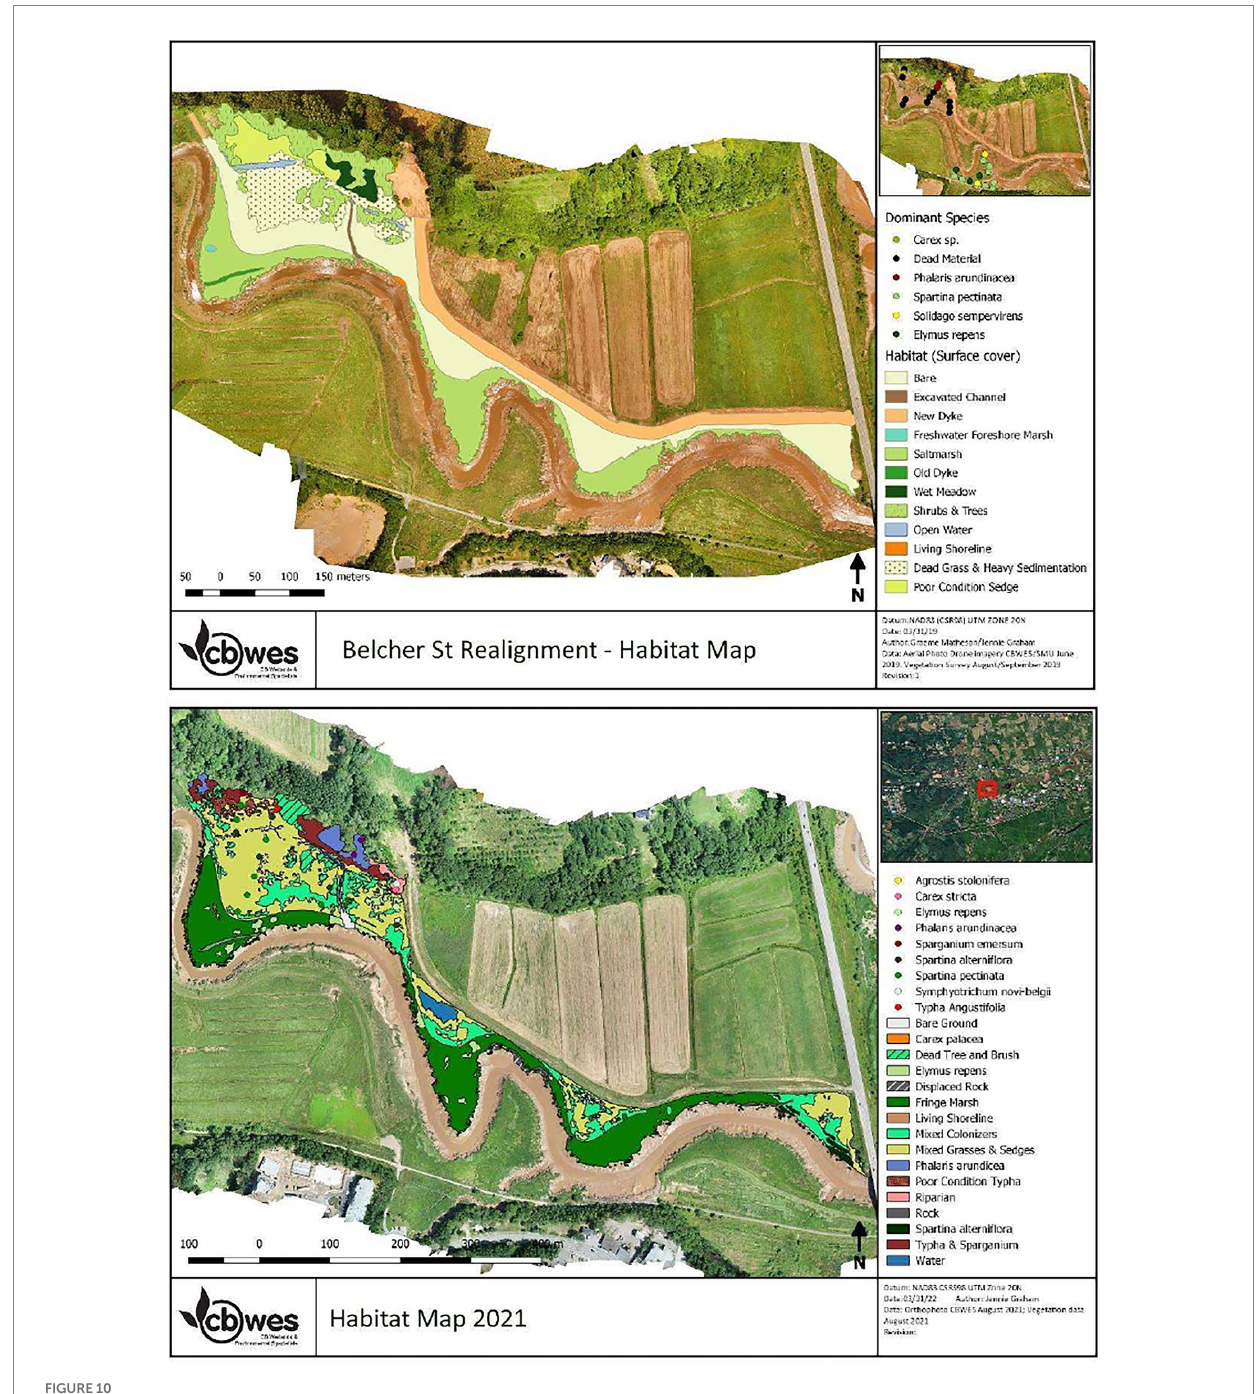
FIGURE 10 Habitat comparison at BEL restoration site: (A) Year 1 and (B) Year 4 post